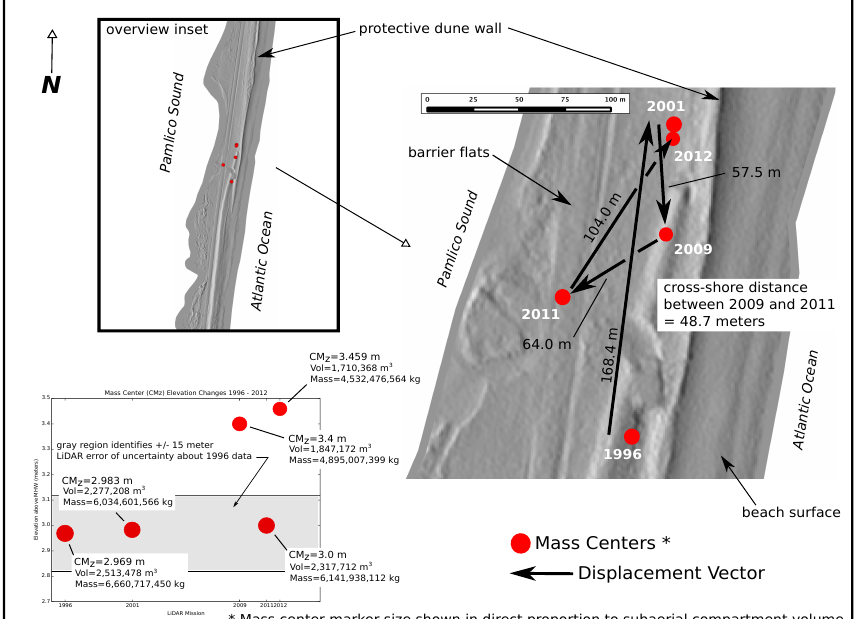
Figure 6. Mass center (CM) displacements for the Hatteras Island study site. The overview insert in the upper left plots the five CMs over the study site in the context of their positions relative to nearby Pamlico Sound and Atlantic Ocean shorelines. The CM changing shift in position for the vertical component ( CM subaerial sediment (sand) volumes and masses. The main plot shows the CMs horizontal components and their displacement through time across the island. CM symbol diameter is proportional to subaerial